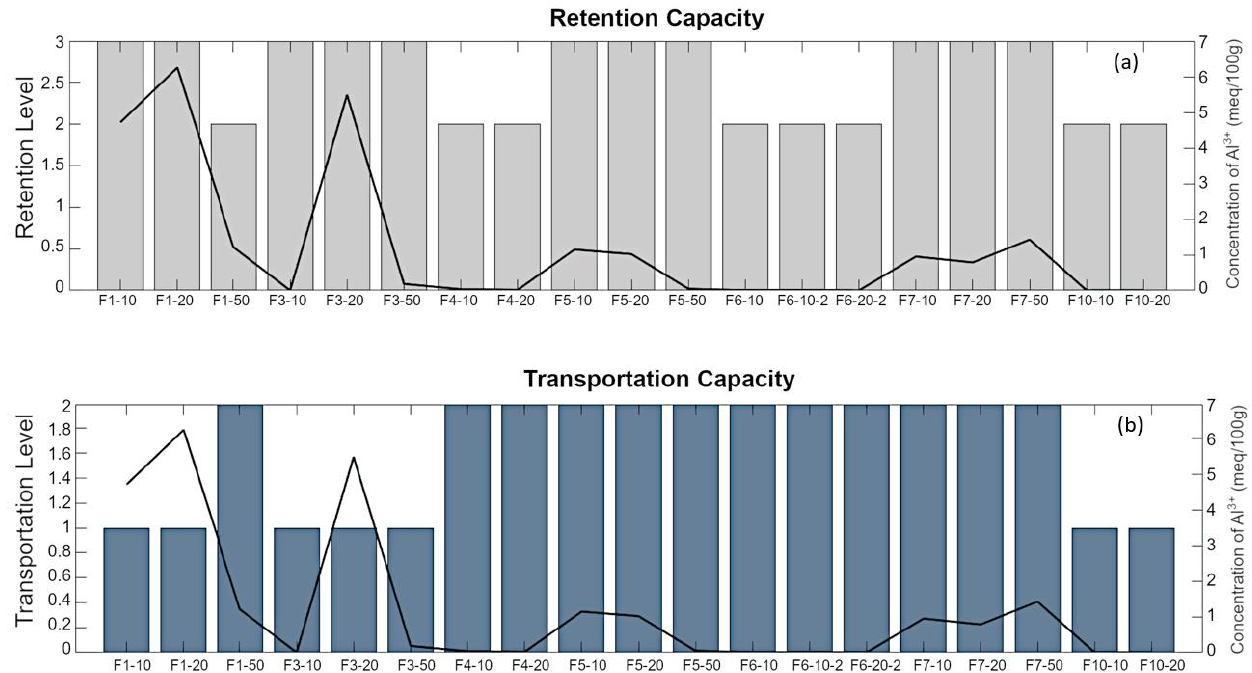
Figure 9. Concentration of Al 3+ (curves) against soil levels (bars) of retention ( a ) and transportation ( b ). The positions of the samples are shown in Figure 8c,d.